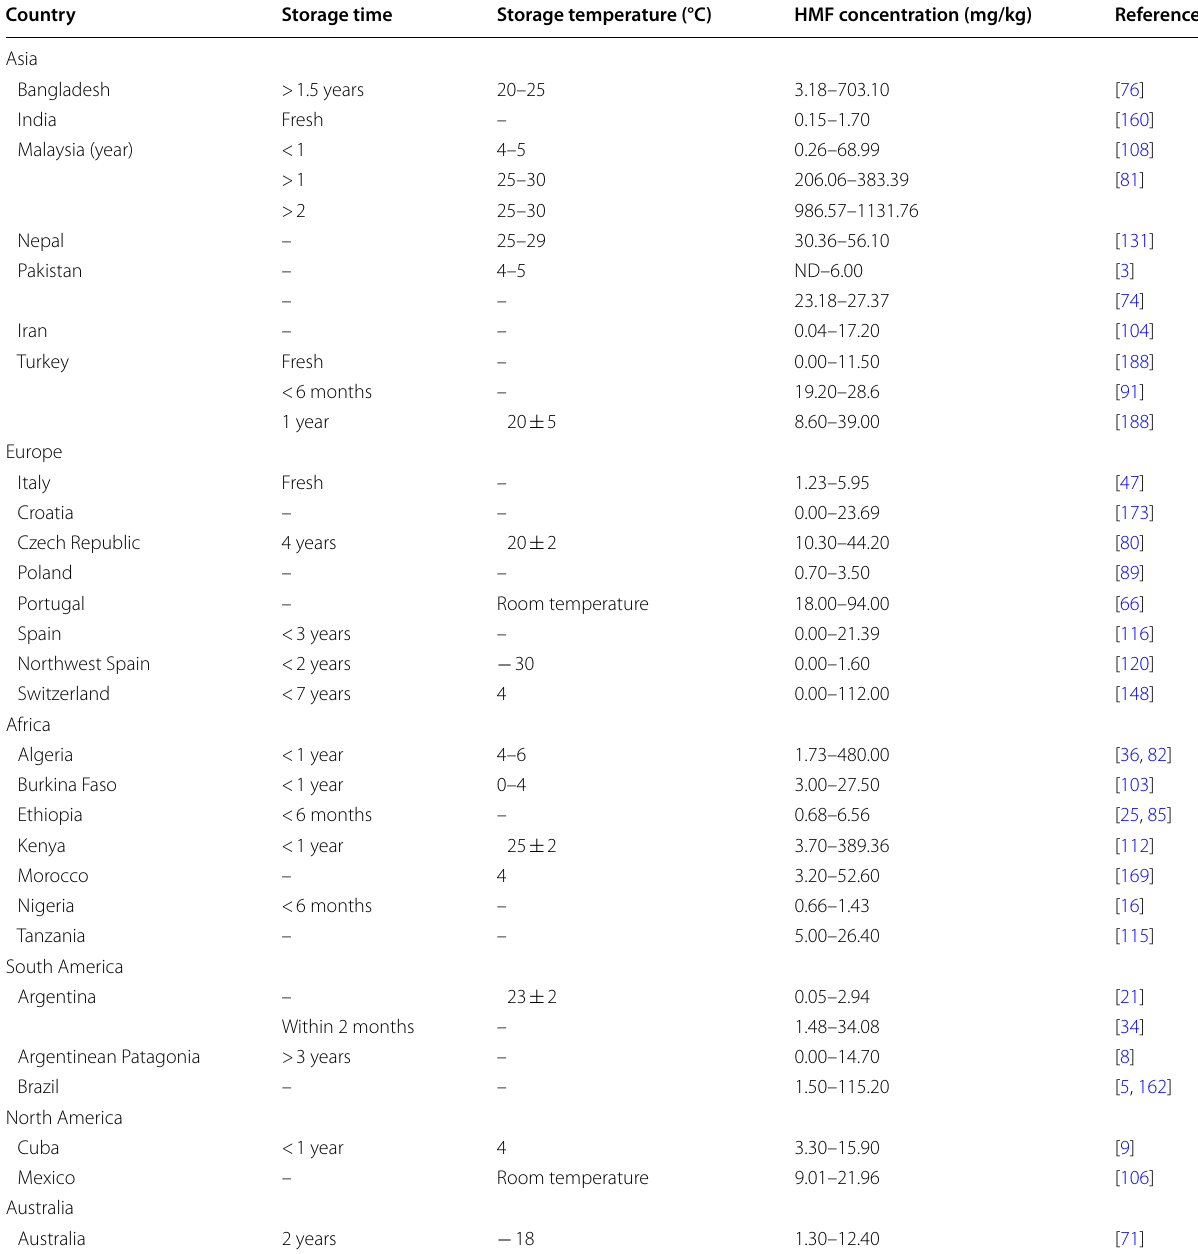
Table 1 Variation in HMF concentration in honey samples based on their storage time and geographical